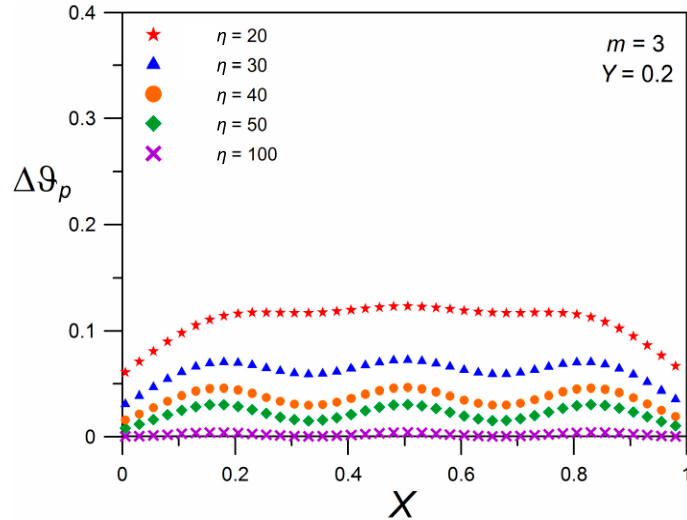
Figure 4. Dependence of dimensionless ground temperature increment ∆ θ p on the dimensionless position coordinate X for various values of η .